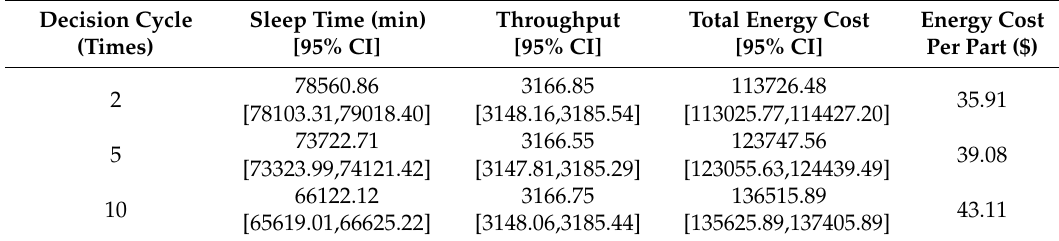
Table 8. System performance comparison of di ff erent decision cycles in S3.